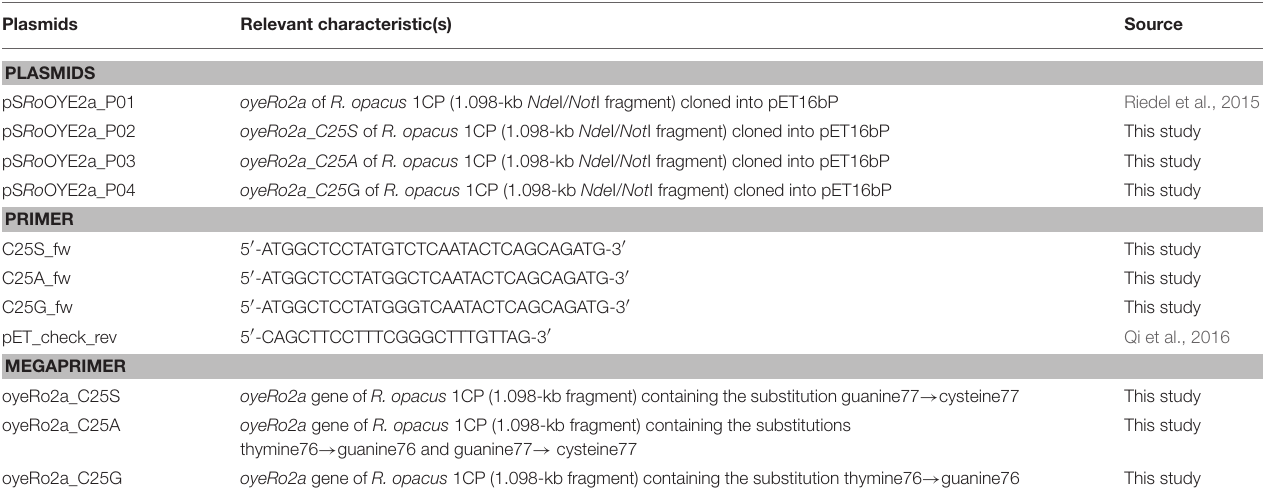
TABLE 1 | Plasmids and primers used in this study.